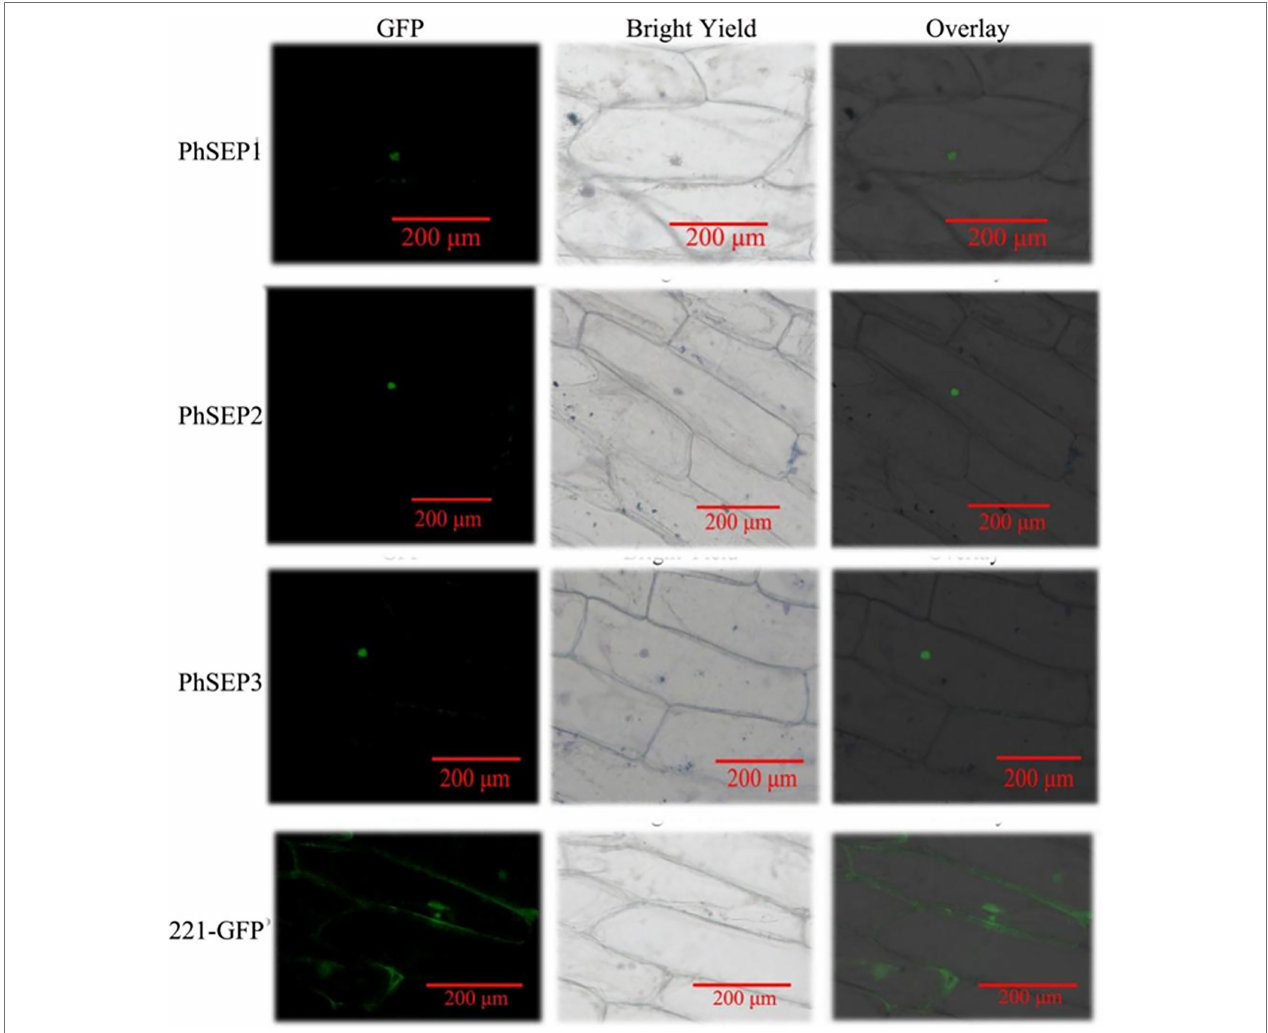
FIGURE 5 | Subcellular localization of the putative PhSEPs in onion ( Allium cepa ) inner epidermal cells. The onion epidermal cells transiently expressing PhSEP1– GFP, PhSEP2–GFP, and PhSEP1–GFP fusion proteins and the EGFP control were visualized through fluorescence microscopy. In each horizontal panel, the extreme left represents GFP fluorescence, the middle image represents bright field, and the right image represents an overlay of the other two